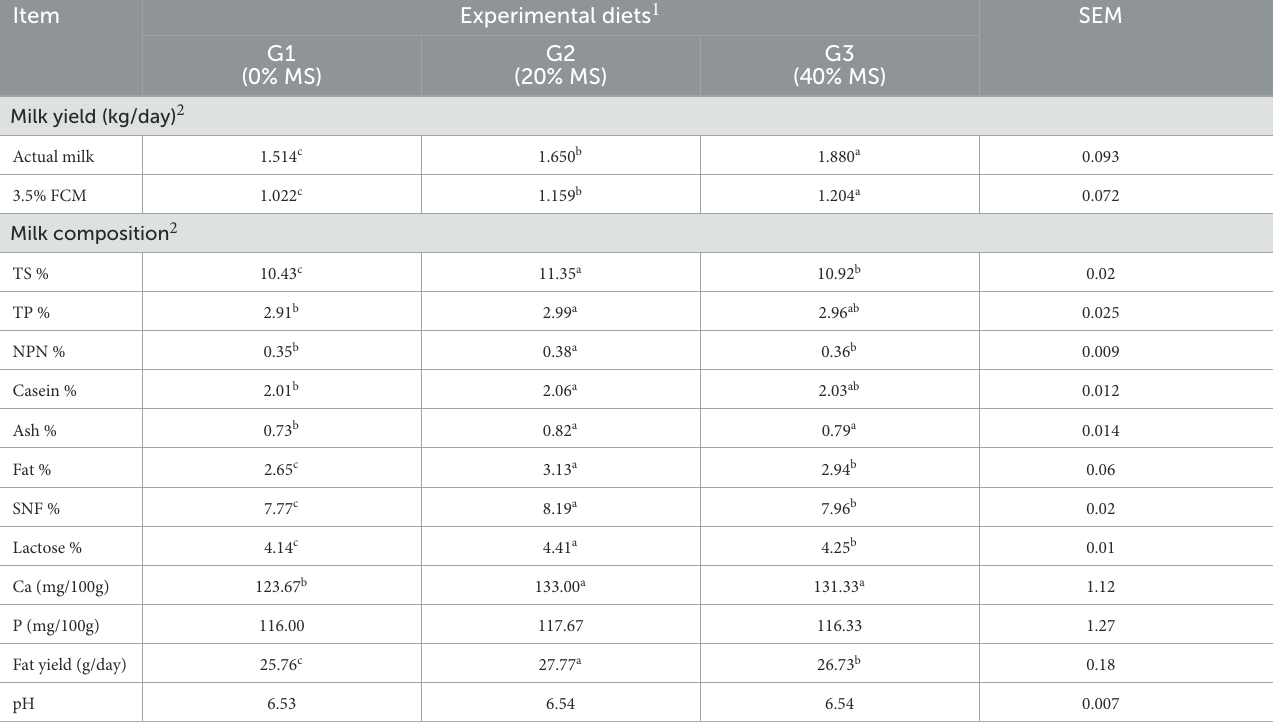
TABLE 8 Milk yield and composition for dairy goats fed different experimental rations.